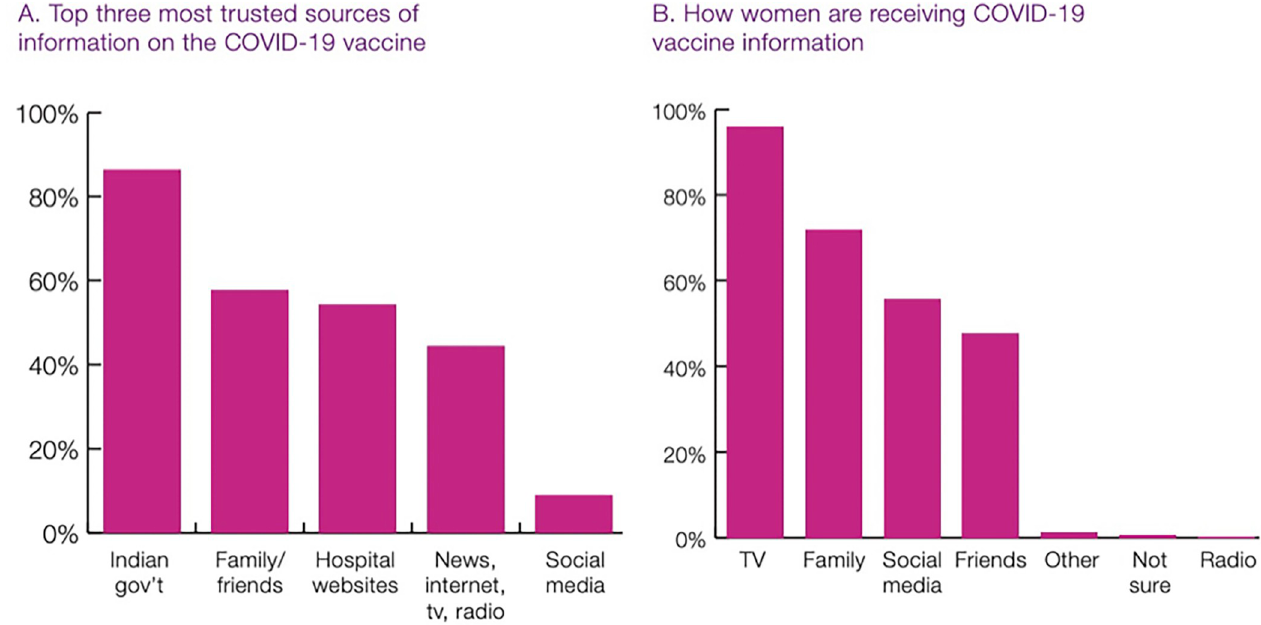
Fig 2. Most trusted and actual sources of information about COVID-19